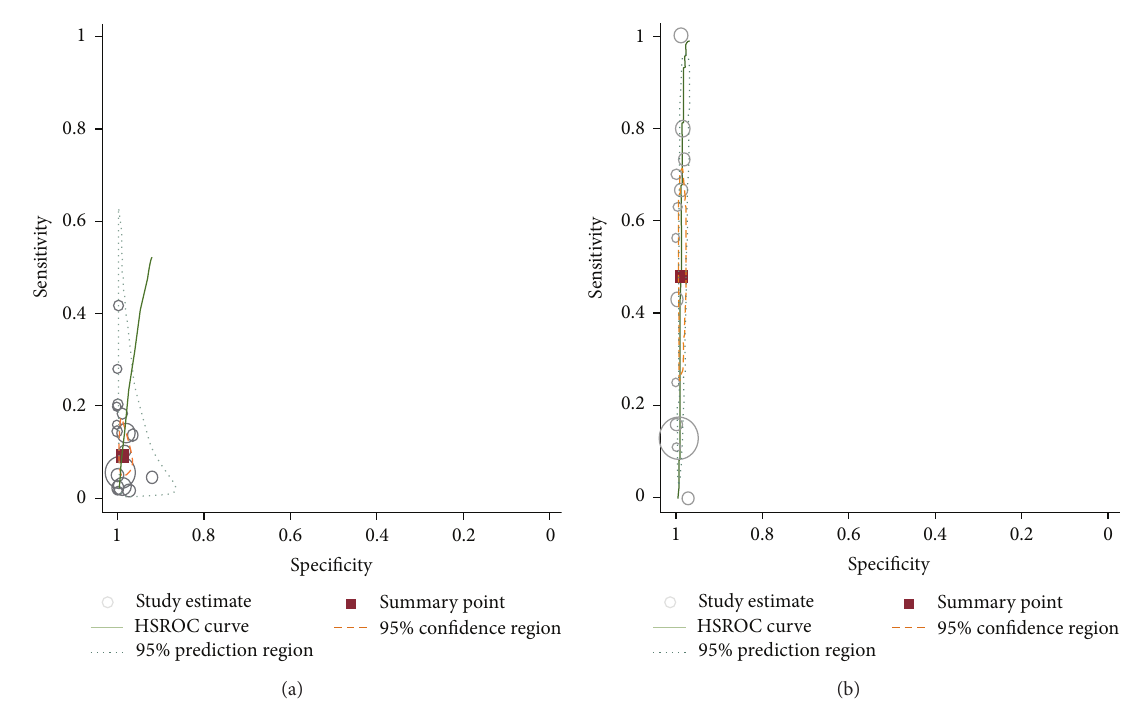
Figure 4: Hierarchical summary receiver operating characteristic (HSROC) curves of anti-CCP antibody assay for the diagnosis of JIA among all included studies (a) and RF+ PA subtype subgroup (b), together with the summary receiver operating characteristic (SROC) curve (solid line) and the bivariate summary estimate (solid square), with the corresponding 95% prediction ellipse (outer dotted line) and 95% confidence ellipse (inner dashed line). The symbol size for each study is proportional to the study size. The bivariate analysis presents studies as sensitivity and specificity data, which are identified by the coordinates of corresponding points in sensitivity-specificity space. Ellipses indicate the bidimensional limits of confidence of sensitivity and specificity for each diagnostic criterion: solid line, hsROC curve; square, bivariate summary estimate; dashed line, 95% confidence area; dotted line, 95% prediction